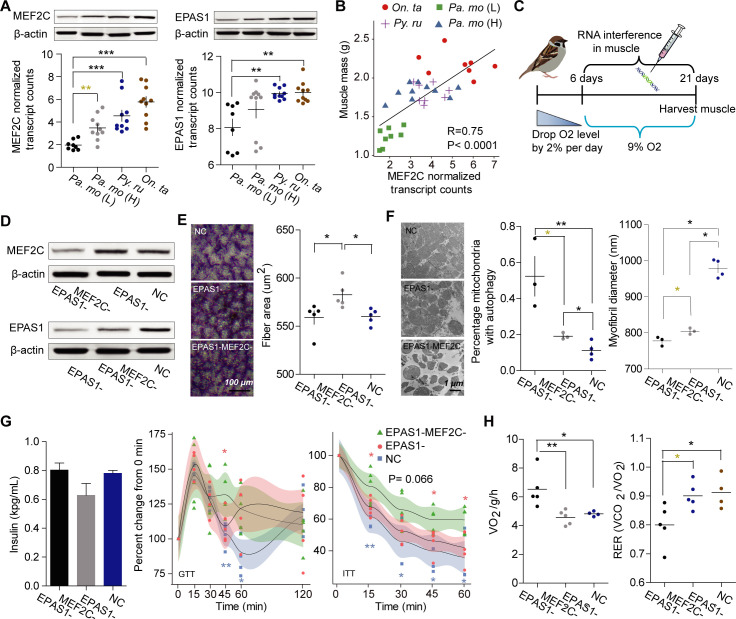
MEF2C and EPAS1 maintain muscle phenotype and glucose homeostasis in chronic hypoxia.(A) The expression of EPAS1 and MEF2C in the muscle was upregulated in snowfinches but only MEF2C was up-regulated in the highland tree sparrow [n = 8 for Pa. mo (L), and 10 for snow finches and Pa. mo (H)]. (B) The expression of MEF2C transcript was significantly correlated with muscle mass (n is the same with the above). (C) Schematic of gradual induction of chronic hypoxia protocol. Tree sparrows were exposed to gradual FiO2 reduction to 9%, injected with target siRNA every three days, and maintained for 15 days. (D) Protein levels of EPAS1 and MEF2C in the muscle decreased after EPAS1 and MEF2C knockdown. (E) SDH of muscle showed a reduction in fiber size in sparrows with downregulated MEF2C expression and high expression of MEF2C and EPAS1(n = 5 each). (F) TEM images of mitochondria showed severe mitophagy in birds with less MEF2C expression and knockdown of EPAS1 improved protein breakdown (n = 3 for siRNA treatment, and 4 for control). (G) Glucose tolerance and insulin sensitivity were reduced in birds with MEF2C knockdown (n = 5 each). (H) knockdown of MEF2C increased oxygen consumption but reduced carbohydrate utilization (n = 5 for siRNA treatment, and 4 for the control group). NC is that birds were injected with equal normal saline.